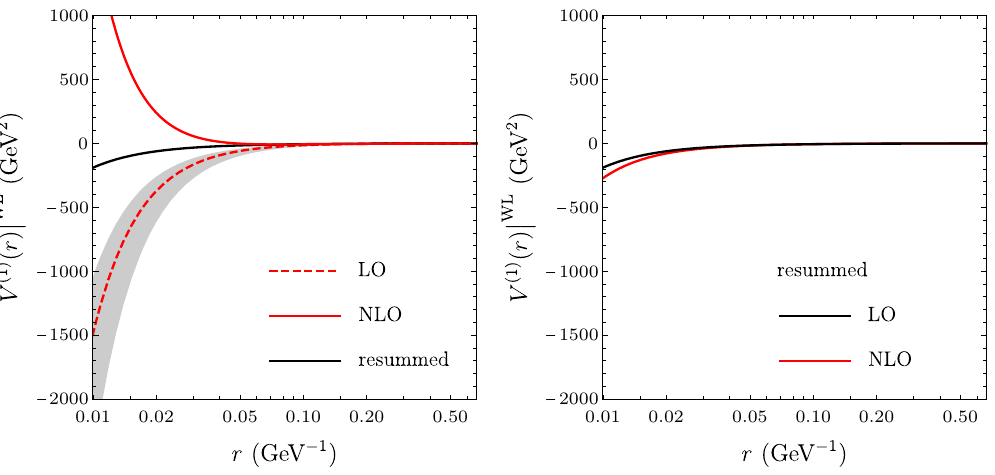
Figure 3 . Left panel: perturbative QCD results for the 1 /m potential in Wilson loop matching at a fixed renormalization scale µ R = 2 . 5 GeV at LO (dashed line) and NLO (red solid line) accuracies, compared with the resummed expression at LO accuracy (black solid line) given in eq. (5.19). The gray band shows the effect of varying the fixed renormalization scale µ R between 1 . 5 GeV and 4 GeV on the LO expression. Right panel: resummed perturbative QCD results for the 1 /m potential in Wilson loop matching at the r -dependent renormalization scale µ r = ( r − 2 + µ 2 solid line) and NLO (red solid line) accuracies. The position-space expression at NLO accuracy has been taken from ref. [52], which is renormalized in the MS scheme at scale 1 GeV.